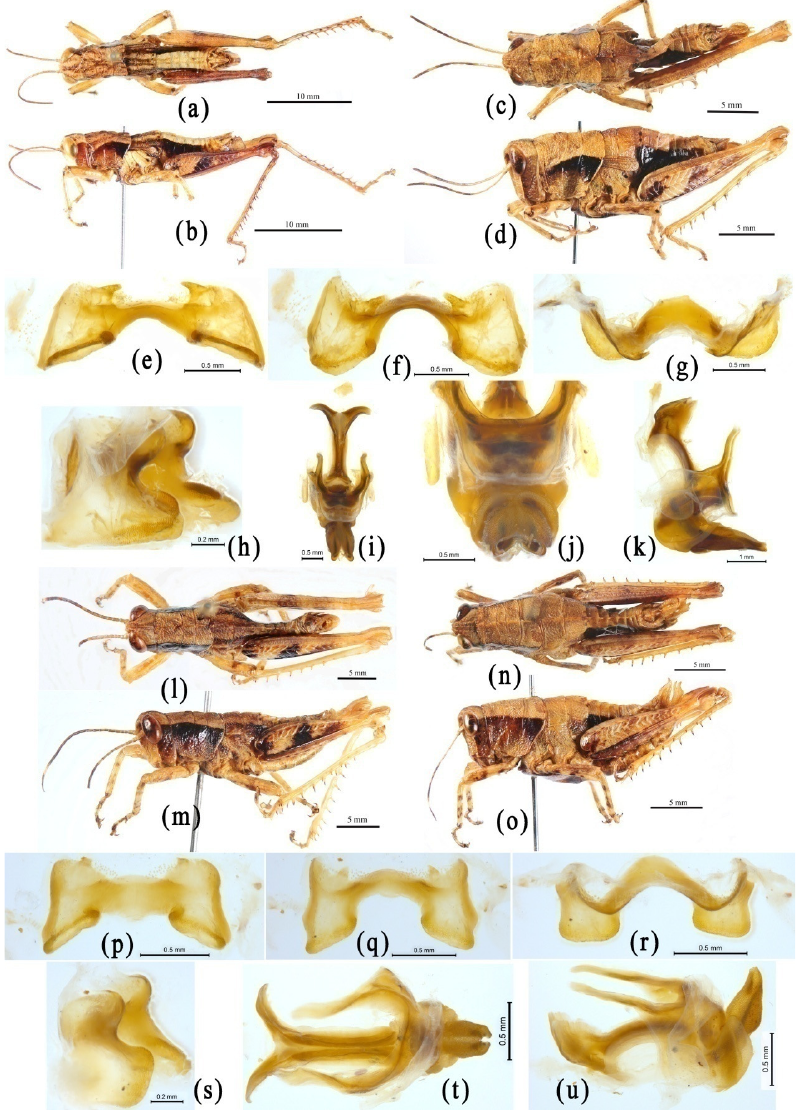
Figure 8. Morphological characters of Menglacris maculata and Ranacris albicornis . ( a – k ) Menglacris maculata . ( a , b ) Male habitus. ( c , d ) Female habitus. ( e – h ) Epiphallus in dorsal, dorsofrontal, frontal and dorsolateral views. ( i – k ) Phallic complex in dorsal and lateral views. ( l – u ) Ranacris albicornis . ( l , m ) Male habitus. ( n , o ) Female habitus. ( p – s ) Epiphallus in dorsal, dorsofrontal, frontal and dorsolateral views. ( t – u ) Phallic complex in dorsal and lateral views.